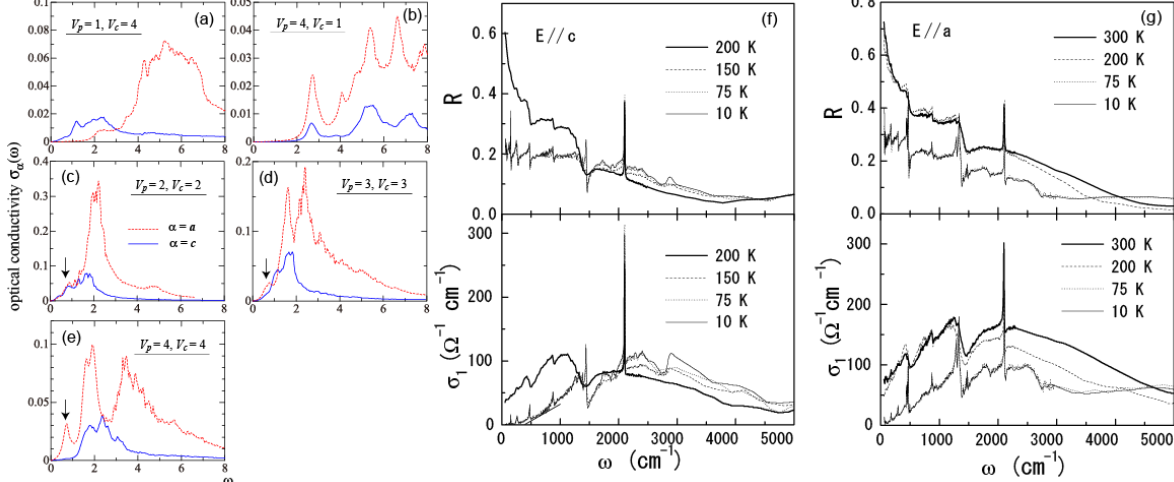
RbZn(SCN) . and 2 4 = 8 and L = 6 [96]. Figure 13a–e a c